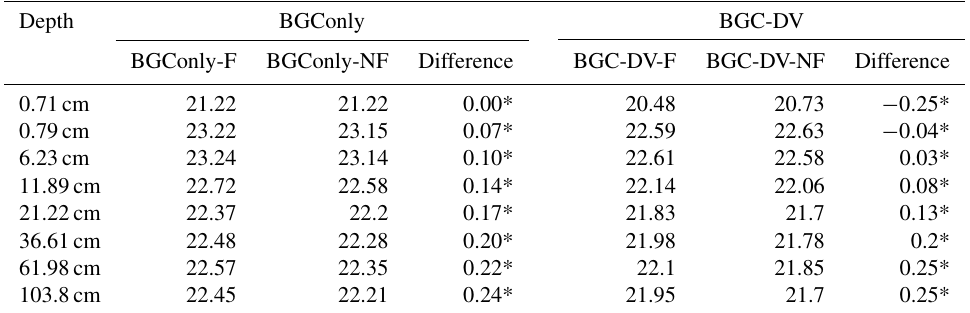
Table 7. Annual mean soil moisture (%) at each soil depth and the difference between with fire and without fire cases (i.e., BGConly- F minus BGConly-NF and BGC-DV-F minus BGC-DV-NF). Asterisk (*) indicates that the difference passed the Student’s t test at the α = 0.05 significance level.